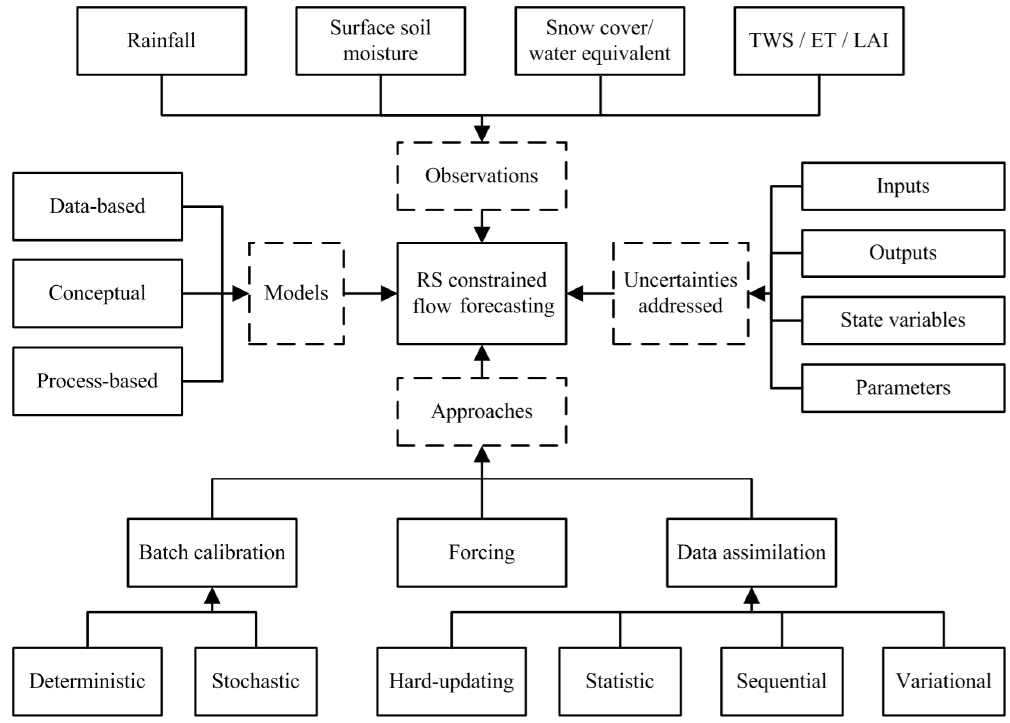
Figure 1. Overview of remote sensing constrained flood forecasting